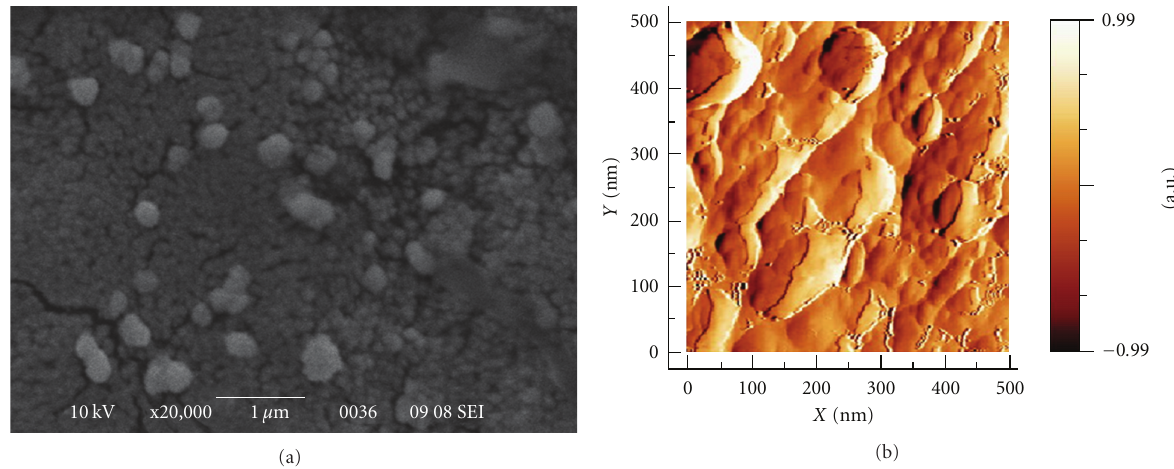
Figure 3: SEM (a) and AFM (b) of electrode type B (microdeposits on glassy carbon from the modifying solution of Pd to Au mixed in atomic ratio 90% :10%).